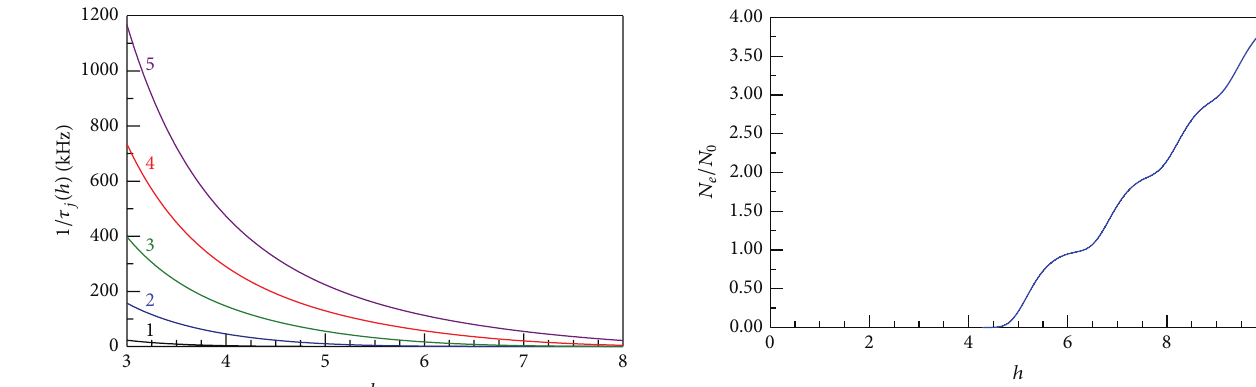
Figure 4: The same as Figure 3 for 2D exponential roughness in the new cell.